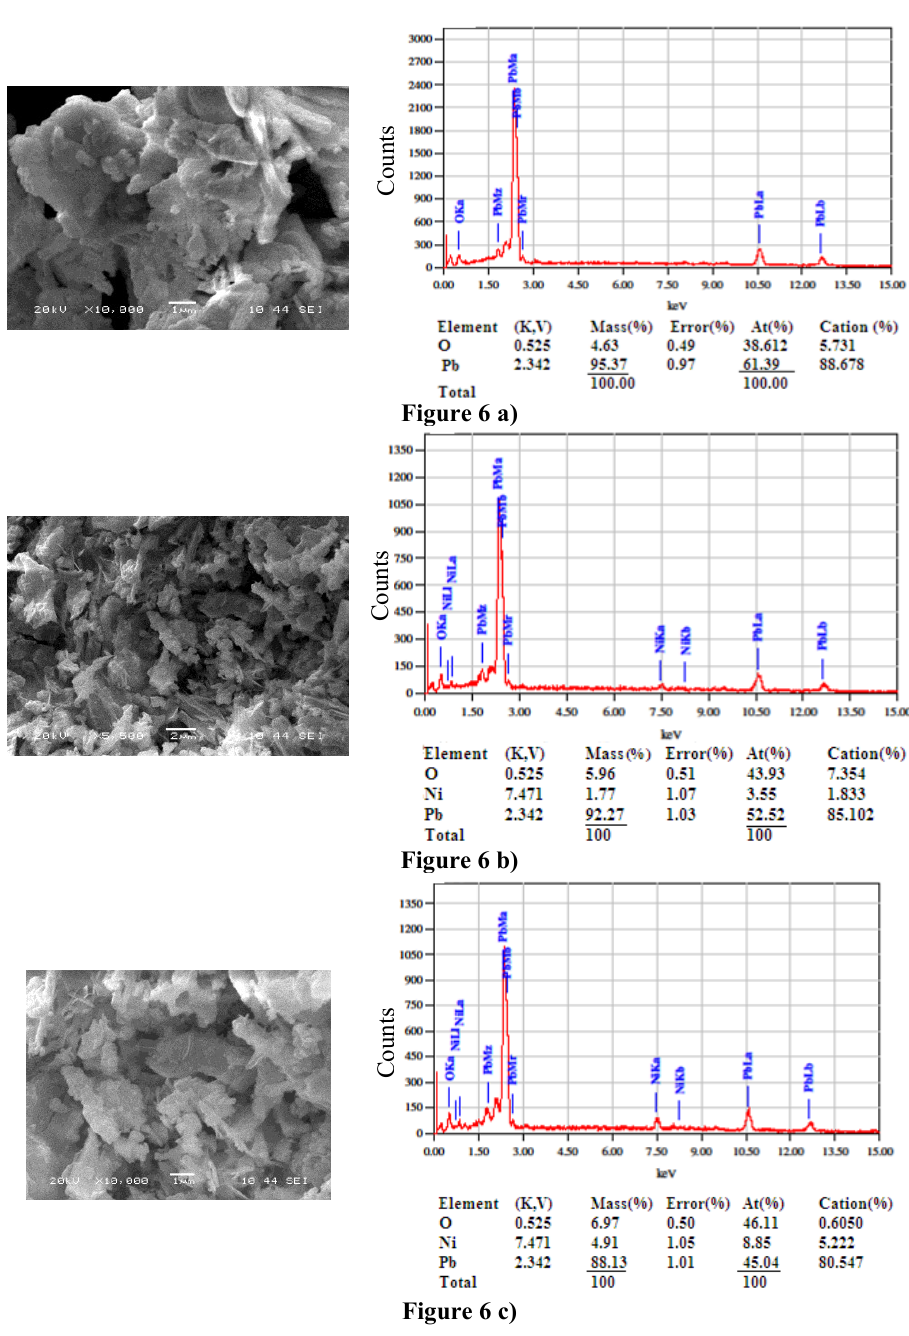
Figure 6. SEM images and EDAX of a) PbO nanoparticle, b) 3% Ni doped PbO nanoparticle, c) 7% Ni doped PbO